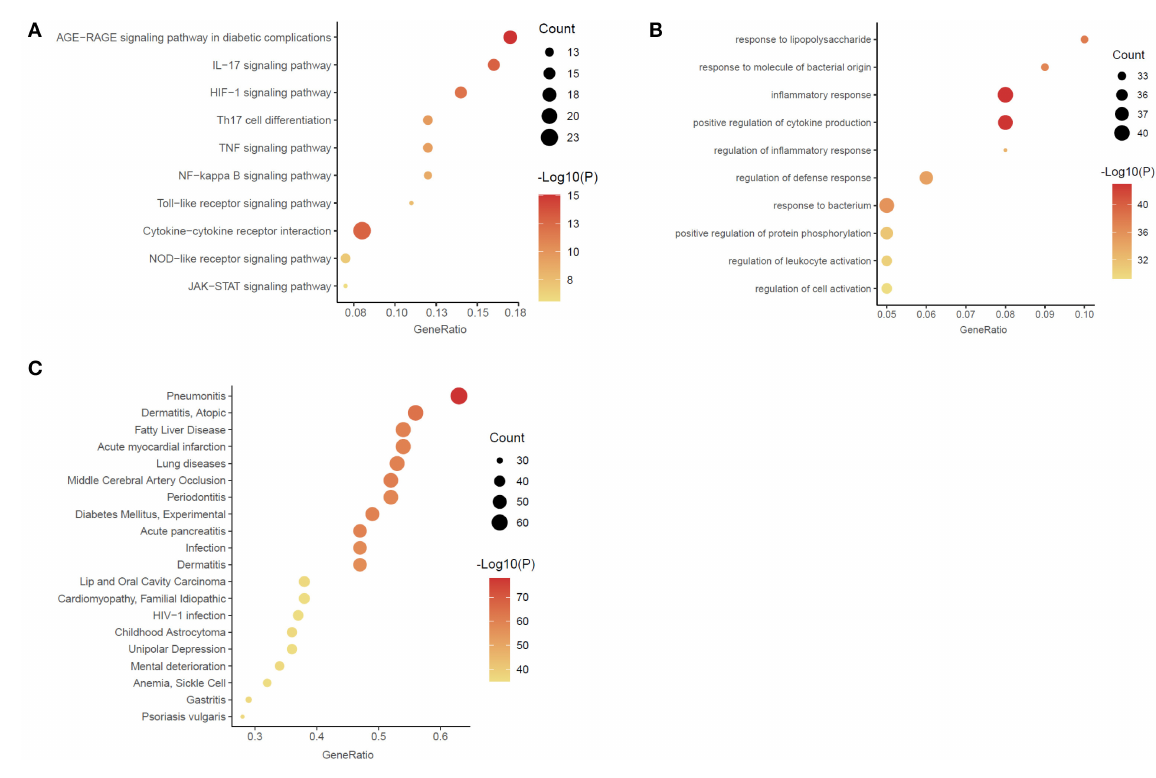
FIGURE4 Enrichment analysis of the chemicals – inflammation genes (A) Gene ontology (GO) functional enrichment analysis. (B) Kyoto Encyclopedia of Genes and Genomes (KEGG) enrichment analysis. (C) DisGeNET (DGN) enrichment